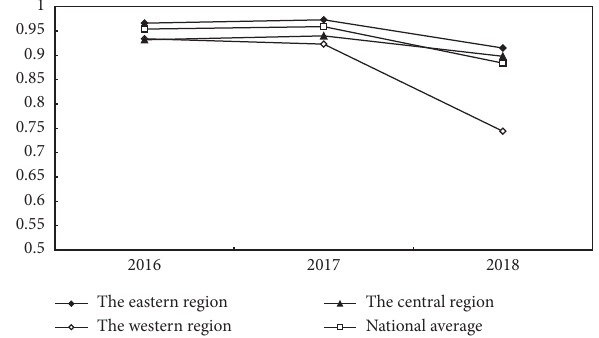
Figure 3: Green innovation economic output efficiency of listed energy companies in China from 2016 to